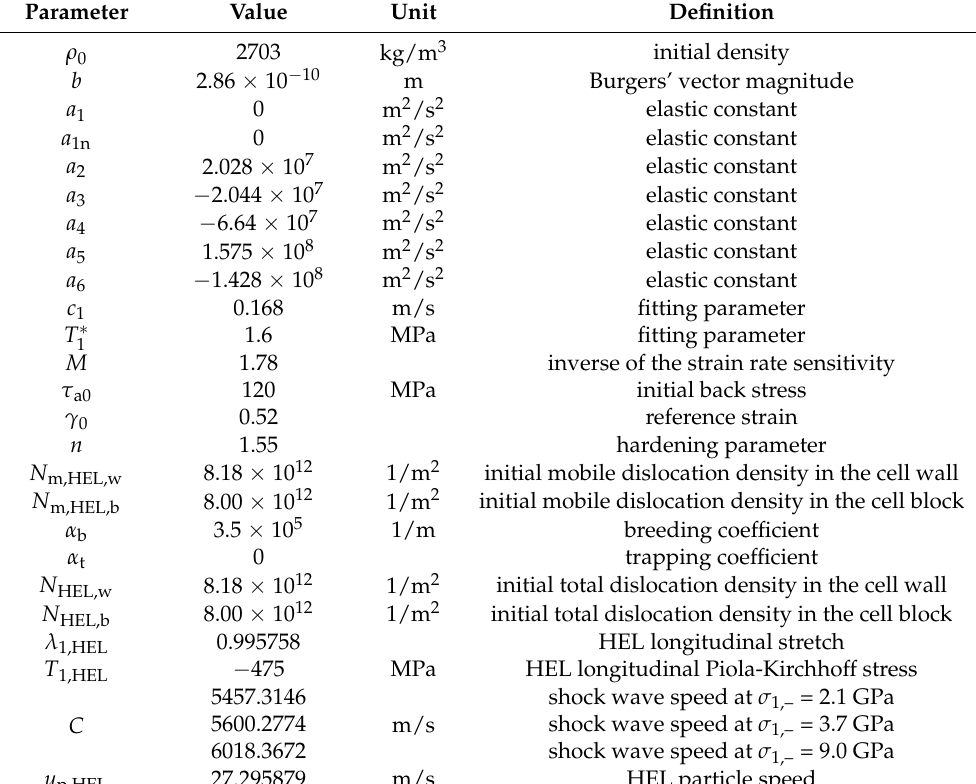
Table 2. Material and operating parameters in Equations (21)–(46) and their values for 6061-T6 Al alloy at ambient conditions (taken from [22] unless specified